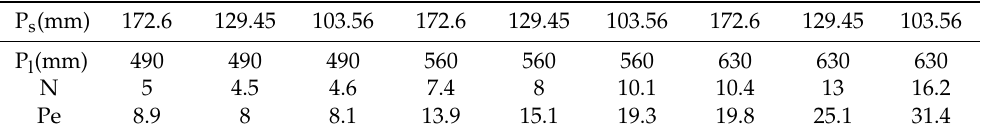
Table 3. Pe number and model parameter